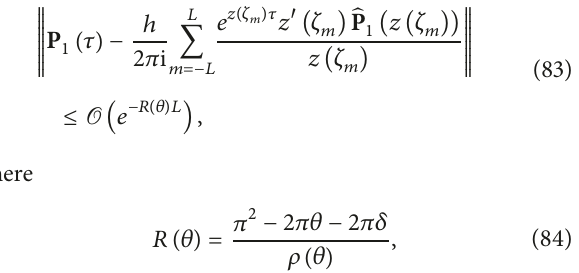
From (76) and (77), we can see that 𝑒 𝑧𝜏 | g 1 (𝑧)/𝑧| 󳨀→ 0 as Re (𝑧) 󳨀→ −∞ and 𝑒 𝑧𝜏 | g 2 (𝑧)/𝑧| 󳨀→ 0 as Re (𝑧) 󳨀→ +∞